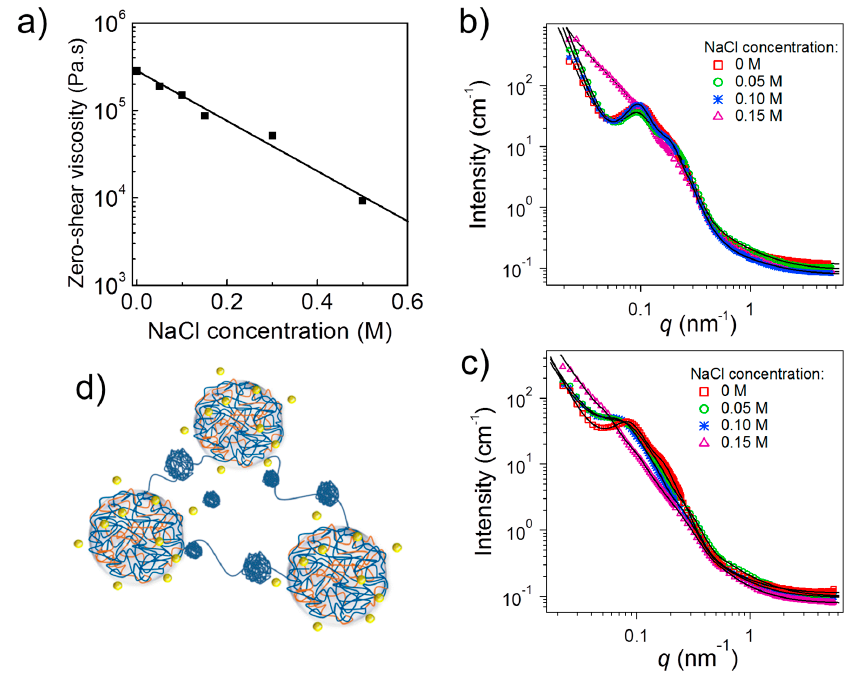
Figure 5. Effect of NaCl on the self-assembled hydrogels from A(QP)A 3 and APA 3 . ( a ) Zero shear viscosity, η 0 , as a function of NaCl concentration of 3 wt % APA 3 aqueous solutions at pH 3.0; ( b,c ) SANS curves of solutions of APA 3 at pD 3.0 ( b ) and A(QP)A 3 at at pD 5.0 ( c ), both at 3 wt % in D 2 O and at 26 °C for different NaCl concentrations (symbols) together with the model curves (lines); and ( d ) sketch of the morphology at a NaCl concentration of 0.15 M. Adapted with permission from [35]. Copyright 2015 American Chemical Society.